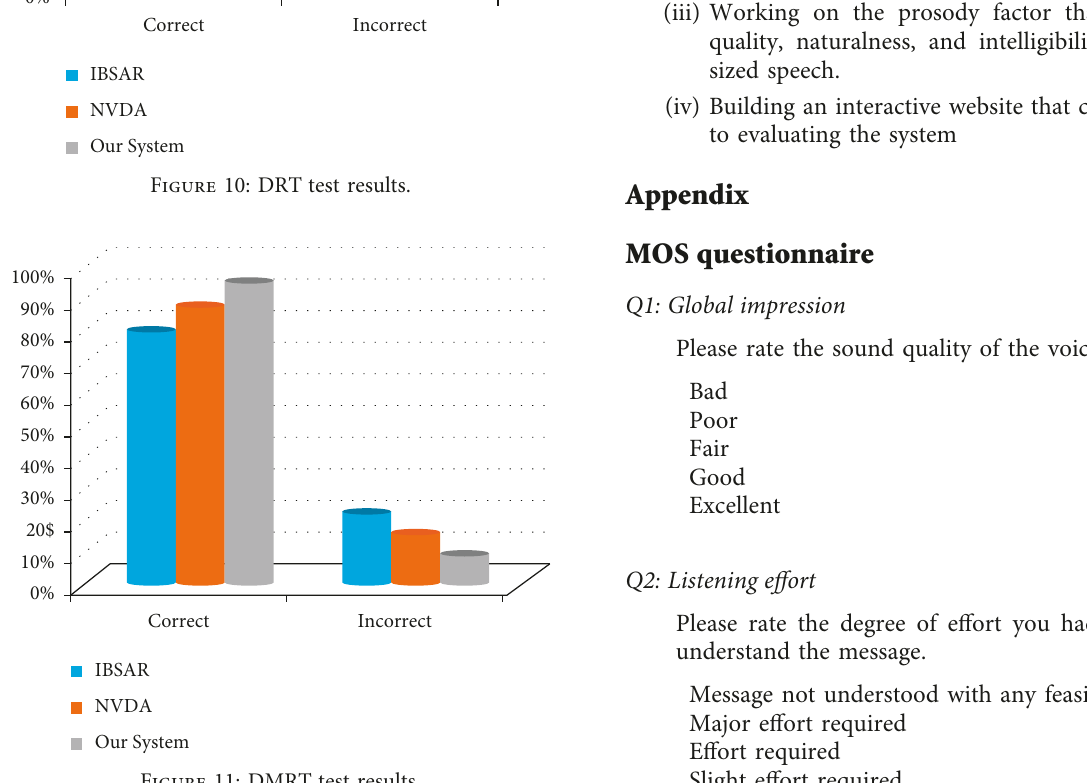
Figure 11: DMRT test